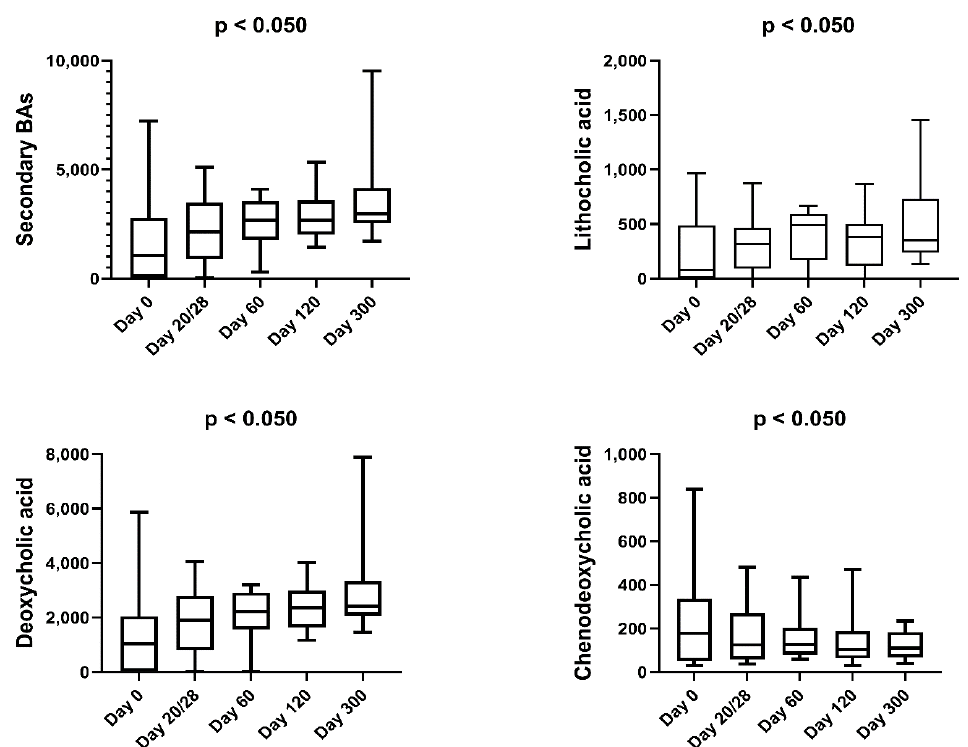
Figure 7. Fecal concentrations of BAs that significantly changed in CON cats over the course of the study. Minimums and maximums are displayed.